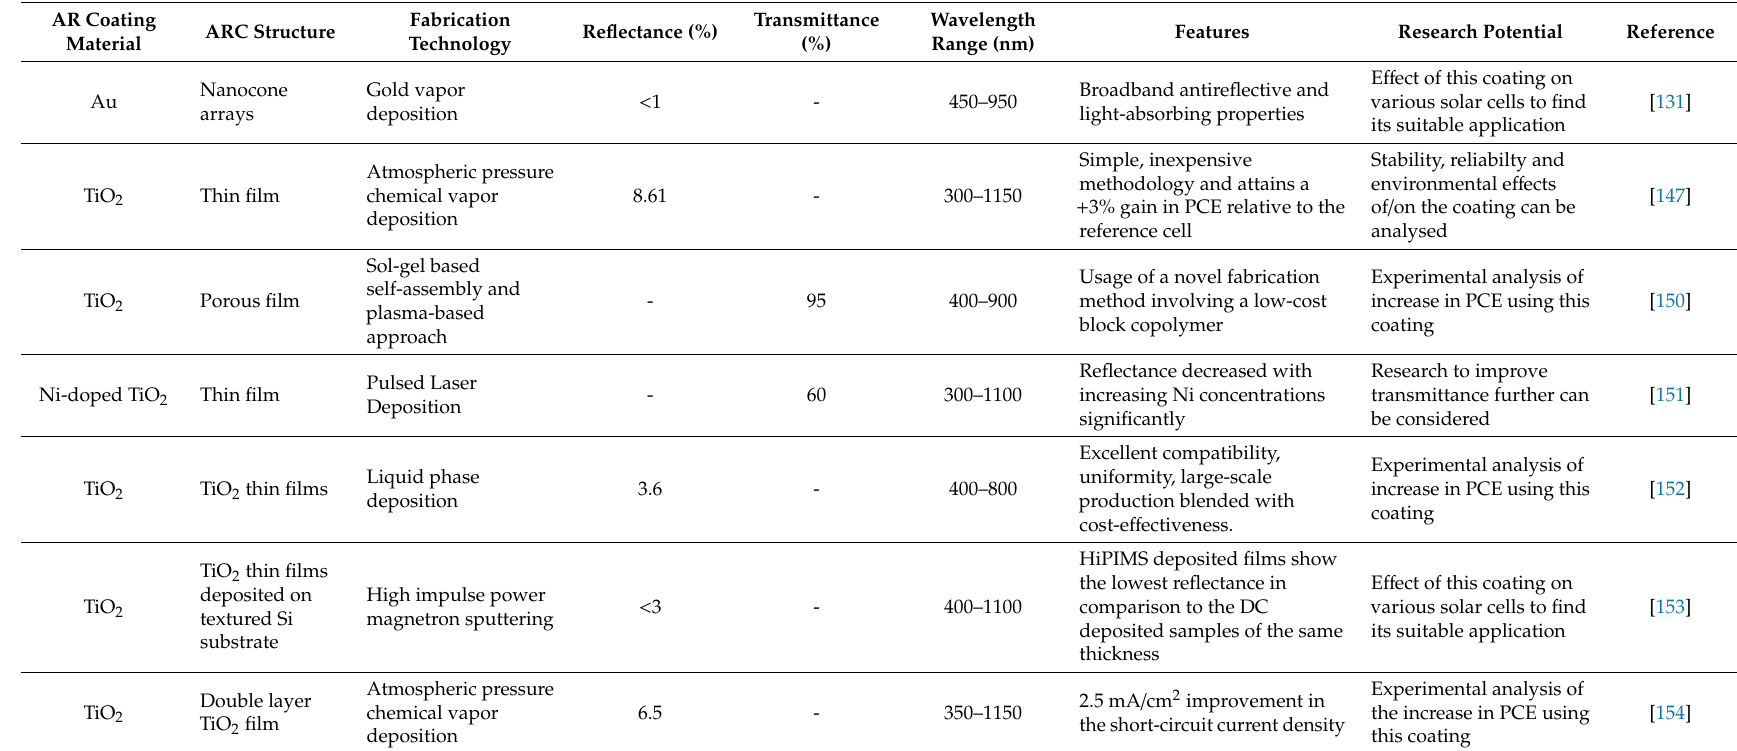
Table 4. Metal based antireflection